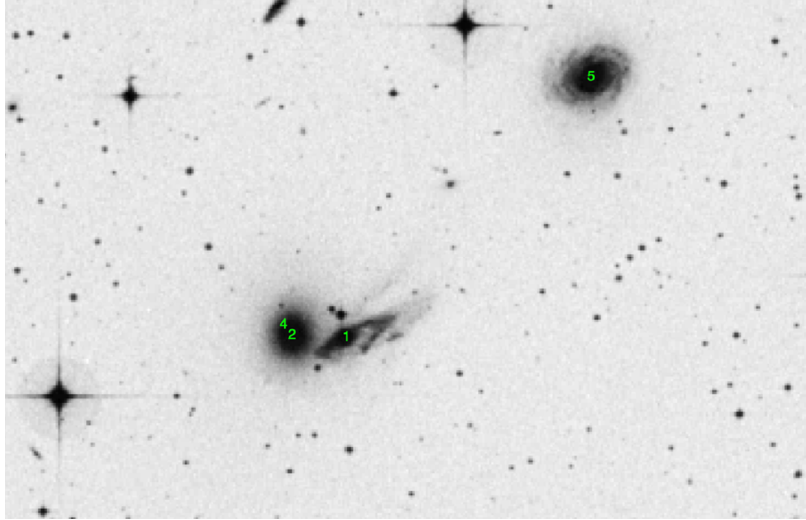
Figure 9. NGG 5153 Group DSS image with X-ray point sources. Table 3. NGC 5153 Group Parameters.